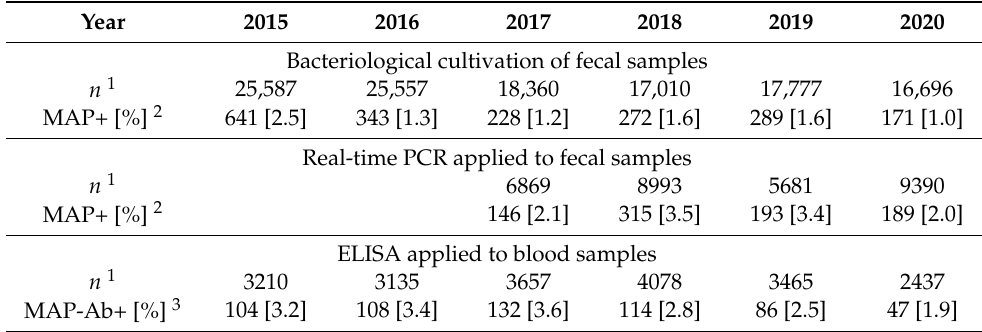
Table 1. Number of samples analyzed for Mycobacterium avium subspecies paratuberculosis (MAP) in the Thuringian JD control program during the years